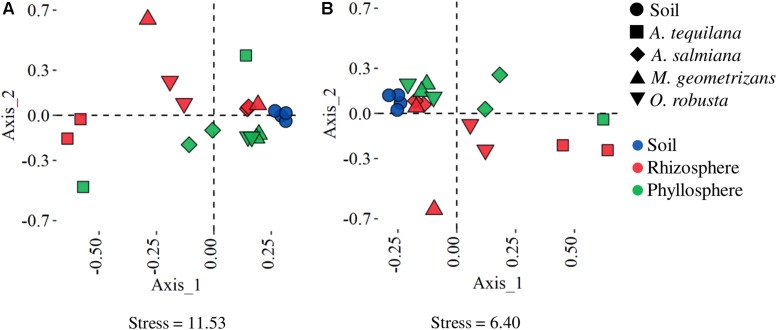
Non-metric multidimensional scaling ordination of Bray–Curtis dissimilarities between samples. The proximity between points represents the similarity between samples based on (A) taxonomic (family) and (B) functional (KO) annotation. A. tequilana phyllosphere from Penjamo (At.P.e) was not plotted in B due to its high dissimilarity.